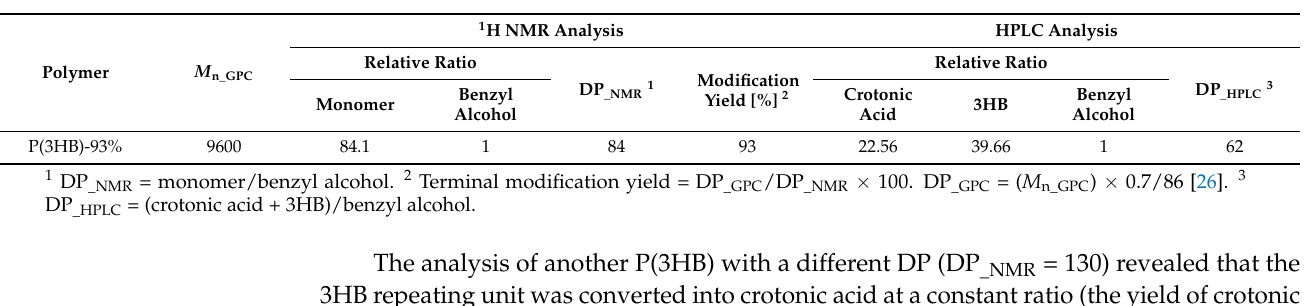
Table 1. Analysis of benzyl alcohol-capped P(3HB) by 1 H NMR and HPLC.